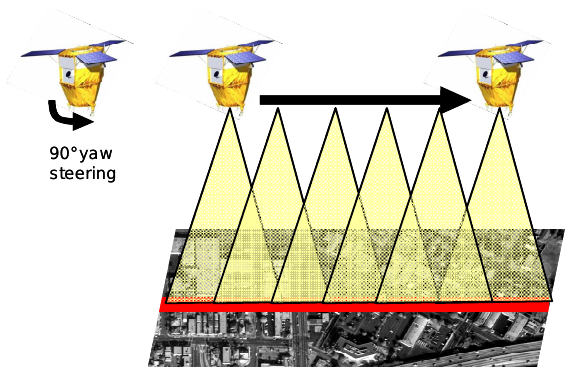
Figure 7. AMETHIST acquisition principle (in red: target landscape line)